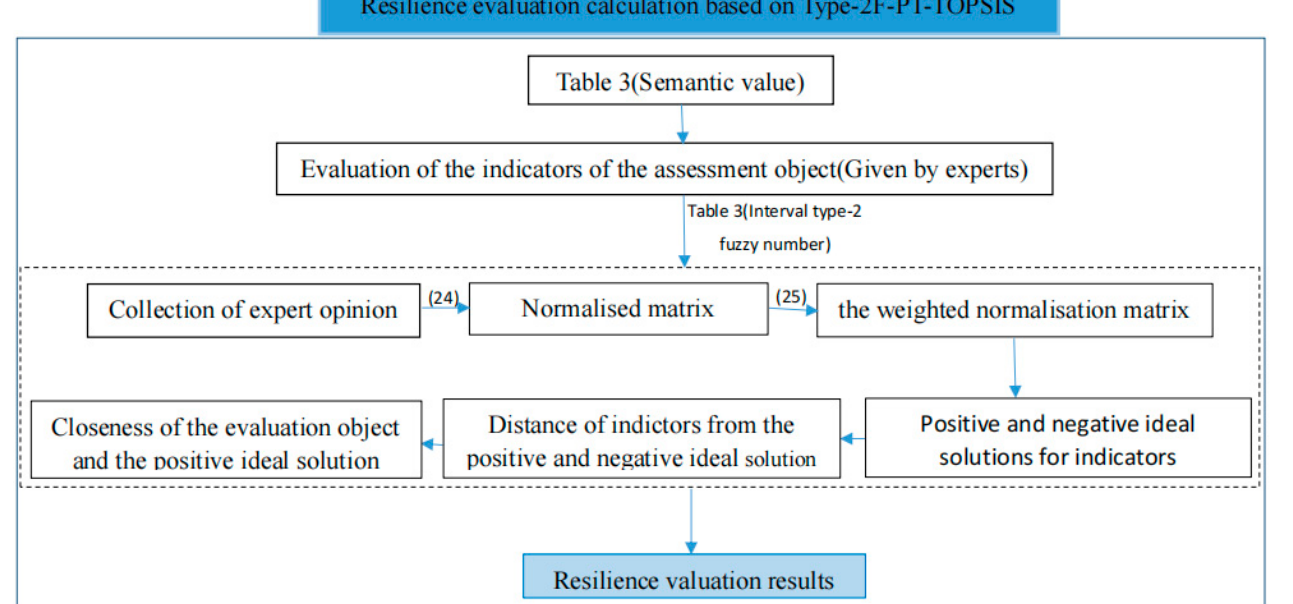
Figure 2. Flow chart for resilience evaluation and calculation based on Type-2F-PT-TOPSIS. Step 1: Based on Table 3, q experts are invited to evaluate the level of resilience under m indicators, and the linguistic value evaluation matrix of the u th decision expert is obtained